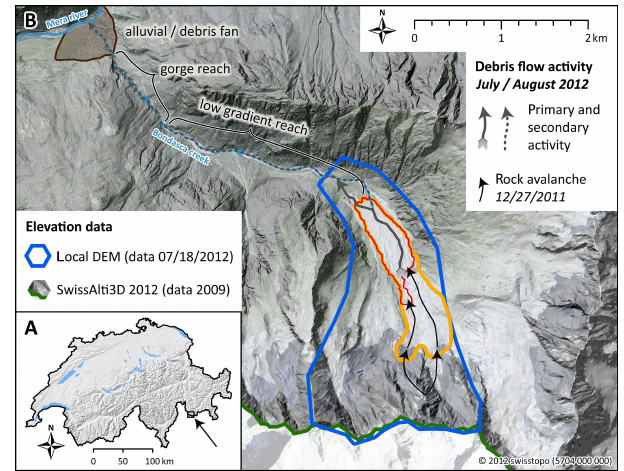
Figure 2. (a) Location of the Bondasca catchment in southeastern Switzerland close to the border to Italy. (b) Perimeter of the 27 De- cember 2011 rock avalanche deposit, including the main deposi- tion area (yellow polygon) and the lower-elevation deposits which were partially exposed to erosion by debris flows in 2012 (red poly- gon). The 2012 post-event digital elevation model (lidar, blue poly- gon) is from 18 July 2012 (data courtesy of the Amt für Wald, Canton Graubünden). Pre-event digital elevation model (lidar) for 2009 is from the SwissAlti3D (version 2012) data set from swis- stopo© 2012 (5704000000). The grey solid arrow indicates the main debris-flow channel formed in